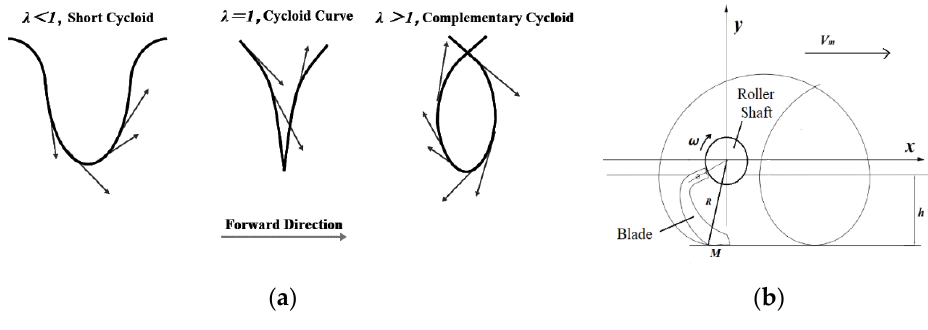
Figure 2. Blade end point motion track.